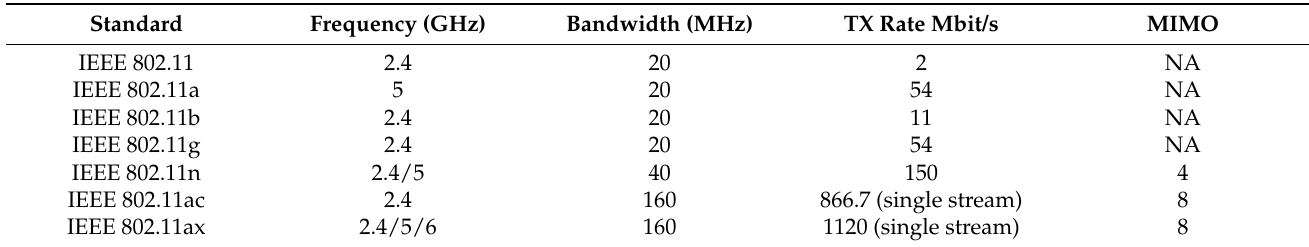
Table 1. IEEE 802.11